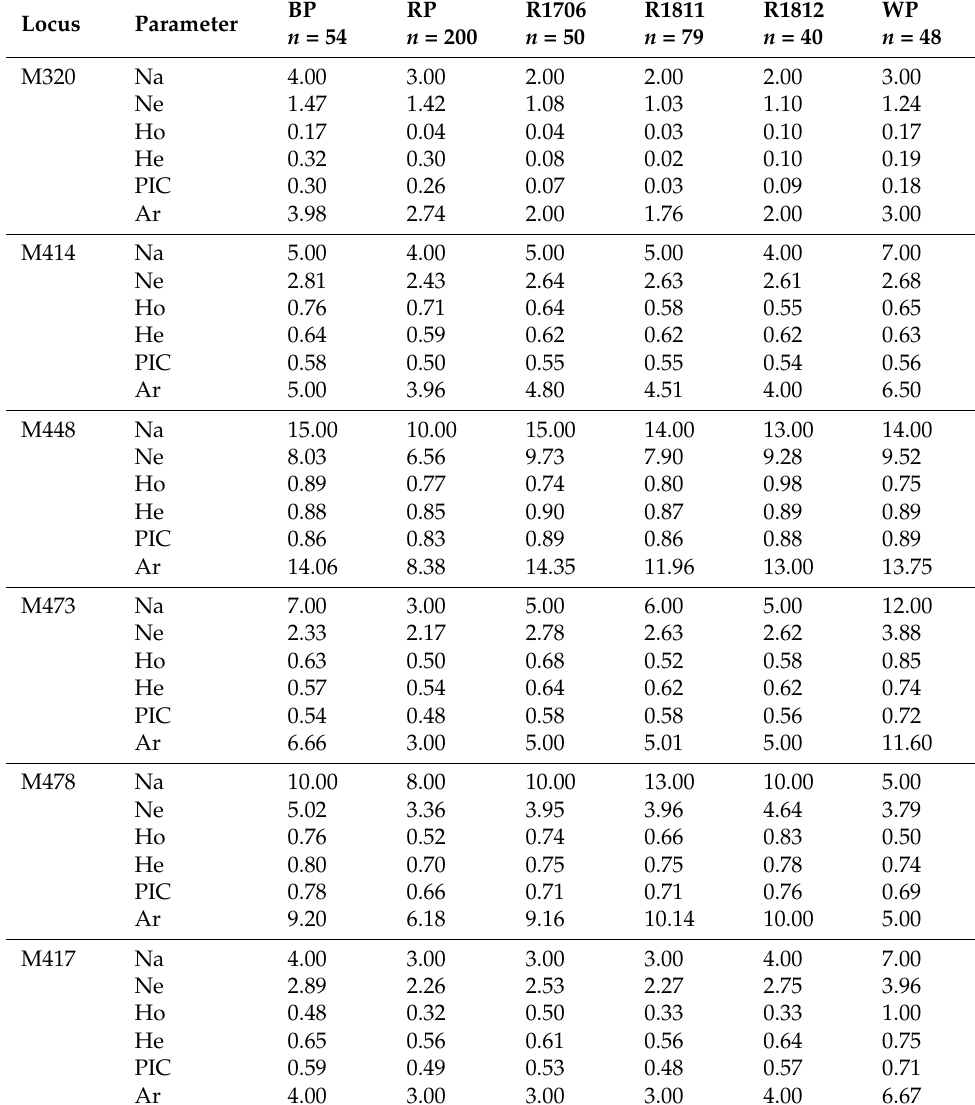
Table 2. Summary genetic statistics of microsatellite loci in black sea